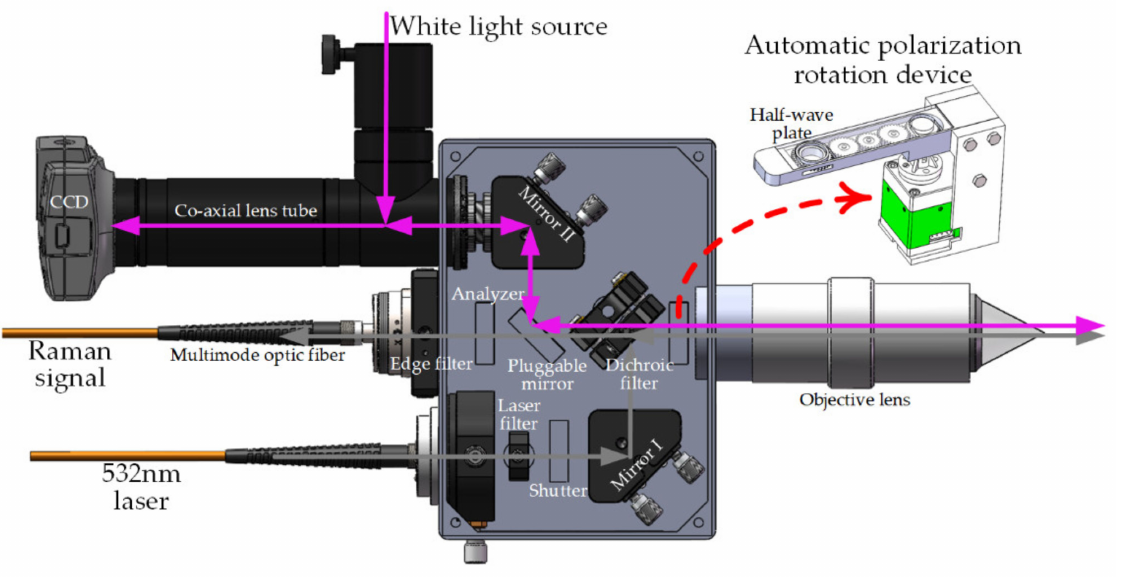
Figure 2. Self-built angle-resolved polarization Raman